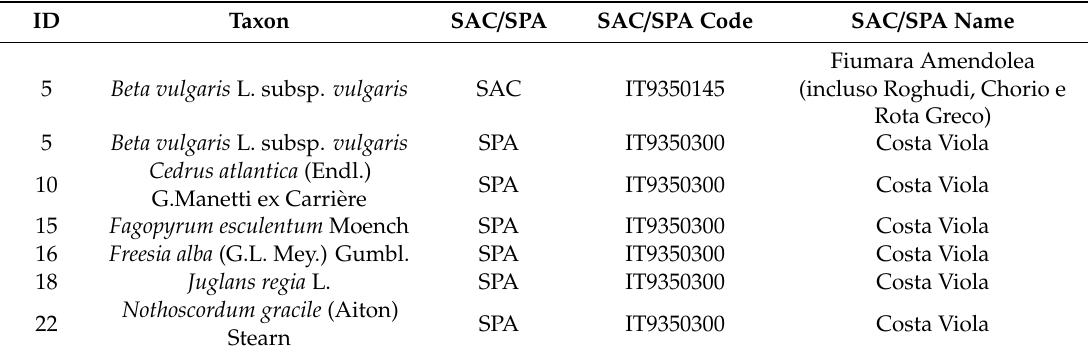
Table 3. Alien taxa found in two sites of the Natura 2000 network in Calabria (Southern Italy,